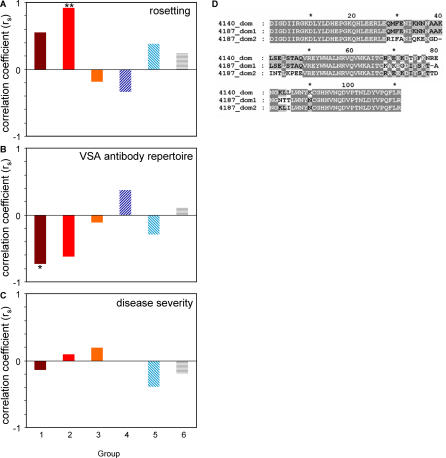
Relationships between the Expression of Each DBLα Sequence Group and Markers of the Host–Parasite RelationshipIn each graph the Spearman's rank correlation coefficient (r
s) is shown for each sequence group. Significance without Bonferroni correction is indicated as follows: *, p < 0.05; **, p < 0.001.(A) Correlation between expression of each sequence group and parasite rosetting (percent of infected erythrocytes forming rosettes).(B) Correlation between expression of each sequence group and host VSA antibody repertoire (the number of a panel of six isolates recognised by the patient plasma).(C) Correlation between expression of each sequence group and severe malaria.(D) Alignments of sequences associated with parasite rosetting. Similar sequences were found to be dominant in two isolates (4140 and 4187) with the highest rosetting frequency. In isolate 4187, the two most dominant sequences (4187_dom1 and 4187_dom2) were highly similar. All three sequences shown have the same sequence signature, “sig2”: LYLD-VERY-KAIT-2-PTNL.